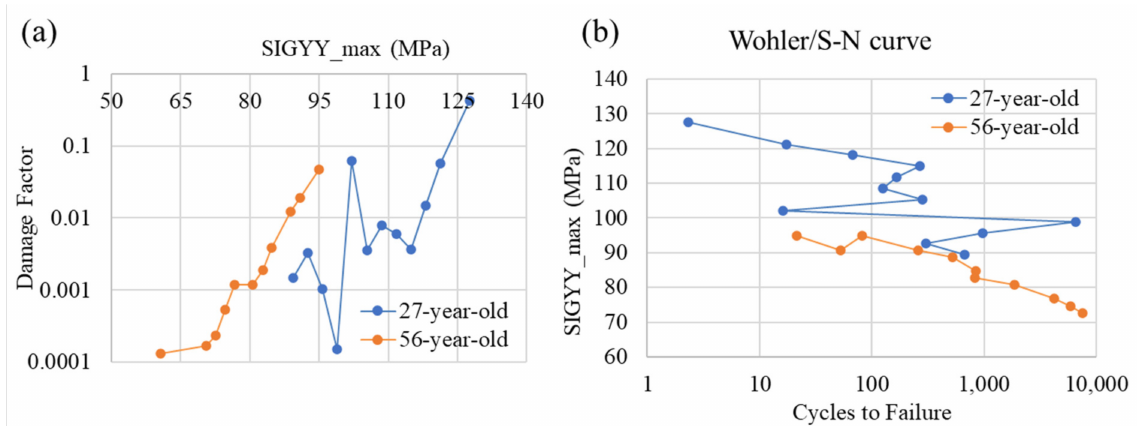
Figure 11. The fatigue damage curve ( a ) and S–N curve ( b ) for two age-related tibia models with